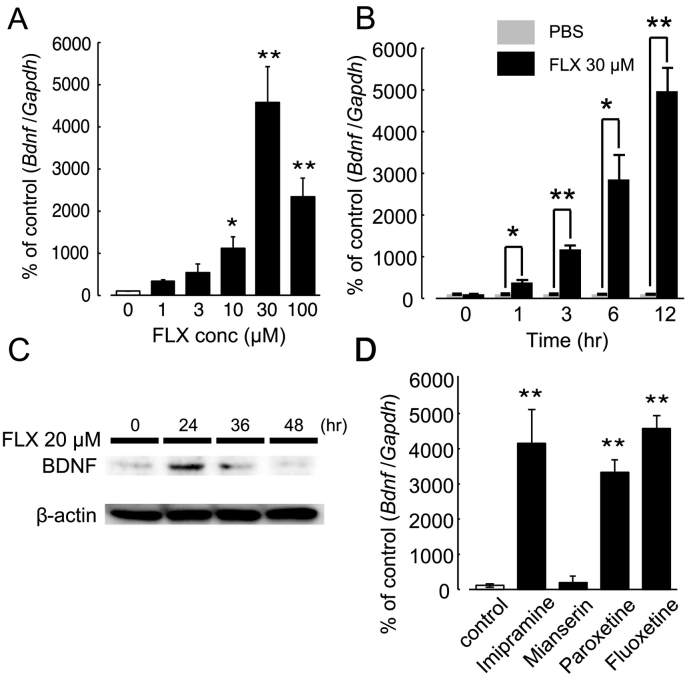
FLX-evoked increase of BDNF in astrocytes.(A) Dose-dependent enhancement of Bdnf mRNA in cultured hippocampal astrocytes by FLX. Cells were incubated with various concentrations of FLX (1–100 μM) or PBS for 12 h in serum-free culture medium. Maximal Bdnf mRNA expression was observed with 30 μM of FLX (*p < .05, **p < .01 vs. control (PBS)). Values are normalized to the PBS-treated control, and shown as a % of the control. Data show the mean ± SEM of representative triplicate measurements. Three independent experiments were performed and similar results were obtained. (B) Time-course of the FLX-evoked increase of Bdnf mRNA in astrocytes. Cells were incubated with FLX (30 μM) or PBS for different periods (from 0 to 12 h) in serum-free culture medium. Gray and black columns indicate the PBS- and FLX-treated groups, respectively. Values are normalized to the PBS-treated control and shown as a % of the control. Data show the mean ± SEM of a representative triplicate measurement. Two independent experiments were performed and similar results were obtained. *p < .05, **p < .01 vs. PBS-treated group. (C) Western blot analysis of FLX-evoked BDNF in hippocampal astrocytes. Cells were treated with FLX (20 μM) for 24, 36 or 48 h, and protein levels of BDNF were assessed by western blot (WB) analysis. Data show a representative WB band of BDNF (upper) and β-actin (lower). At least 3 independent experiments were performed and similar results were obtained. (D) Effect of other anti-depressants on the expression of Bdnf mRNA in hippocampal astrocytes. Cells were treated with different anti-depressants including Imipramine 30 μM, Mianserin 30 μM, Paroxetine 30 μM and Fluoxetine 30 μM for 12 h. Bdnf mRNA levels in each group were measured and compared. Data show the mean ± SEM of the % of controls (without anti-depressants), showing representative triplicate measurements.